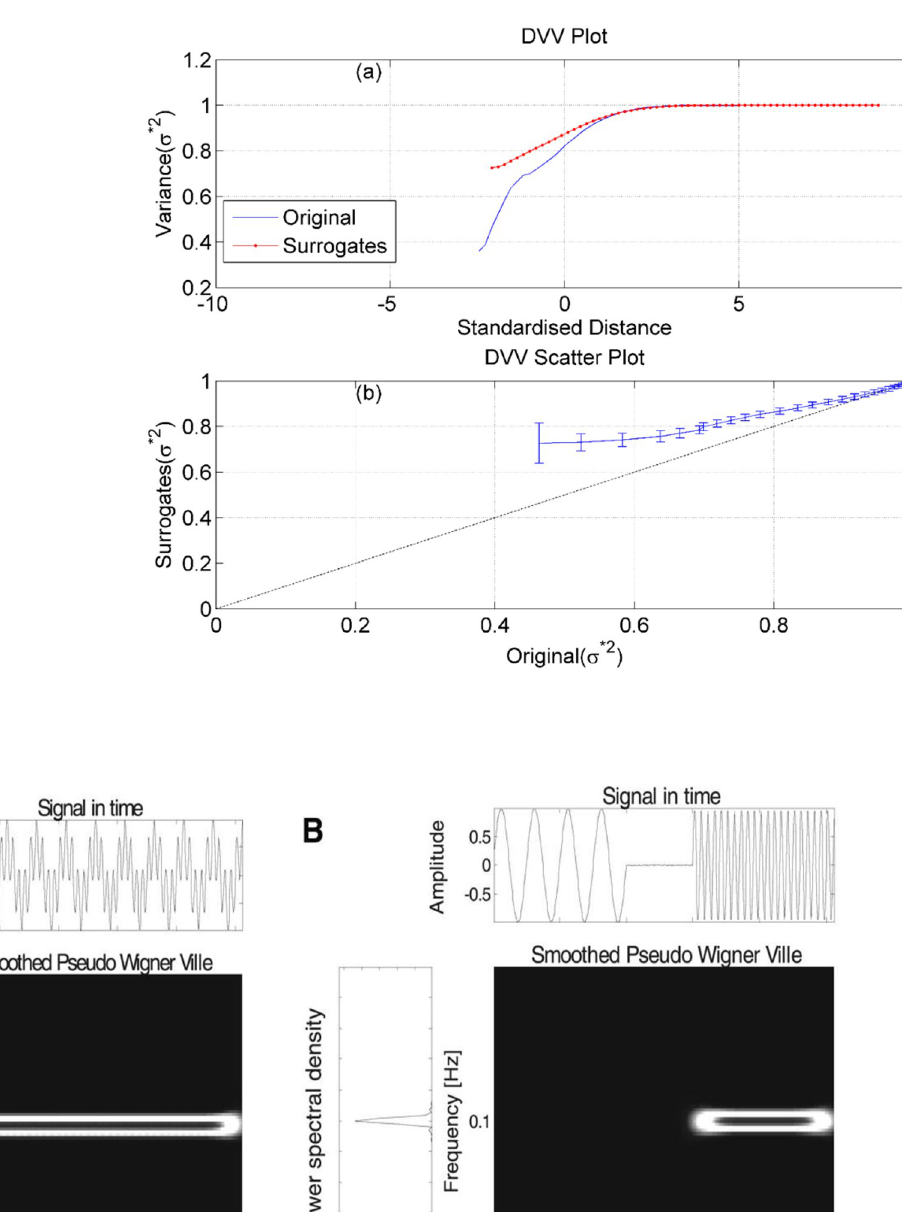
Fig. 3 a DVV plots of the original and surrogated K index data series with, 𝜏 d = 2 and m = 13 , b scatter plot with error